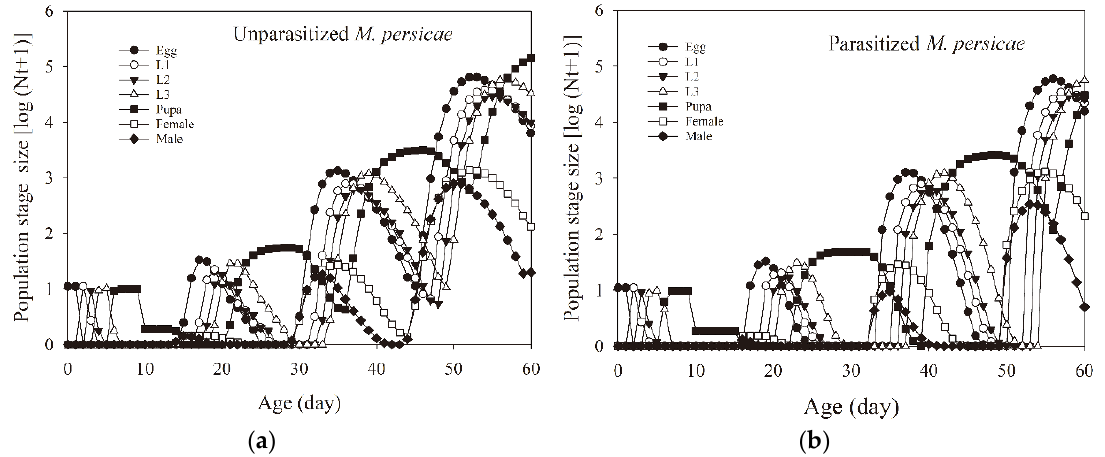
Figure 4. Population growth of Aphidoletes aphidimyza fed on unparasitized Myzus persicae ( a ) and parasitized Myzus persicae ( b ) by computer simulation .